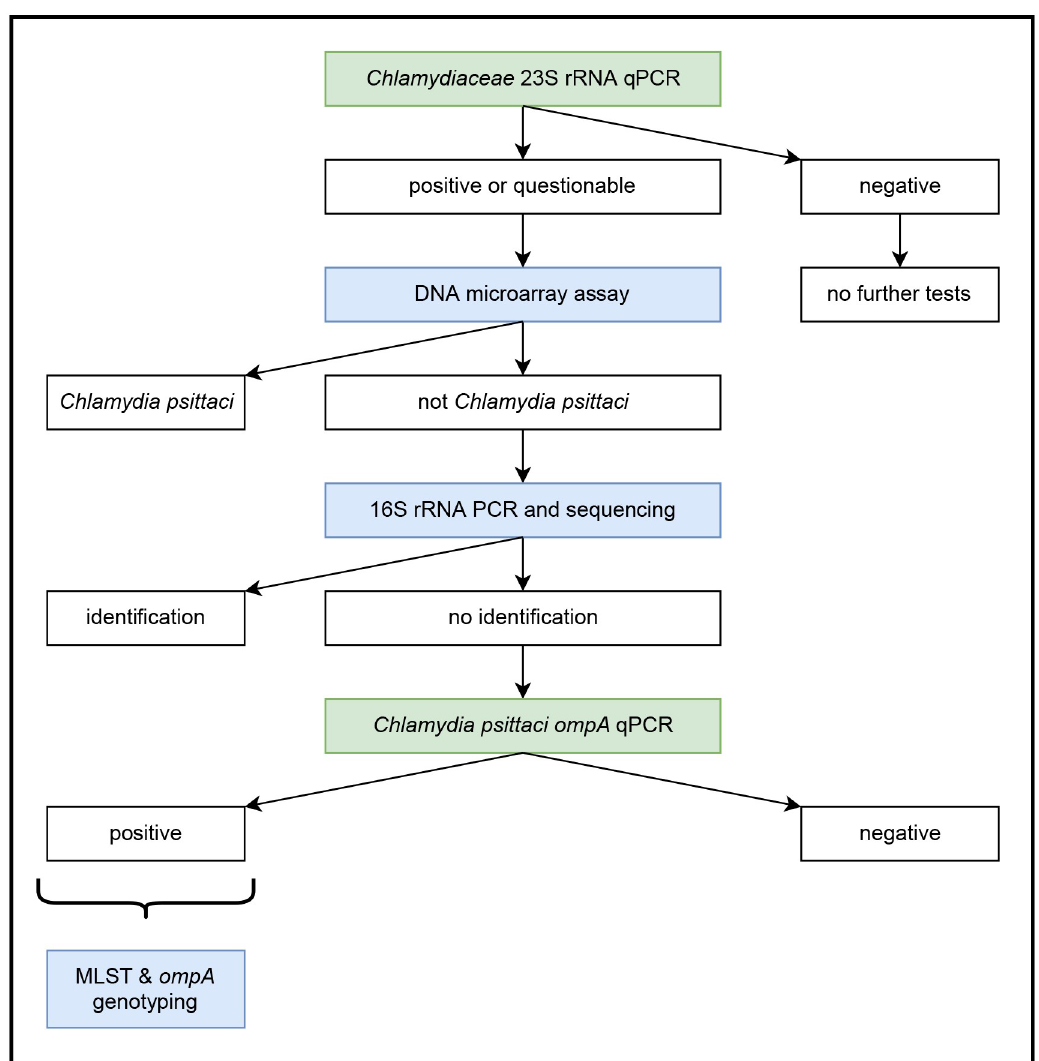
Fig 1. Decision tree for step-wise typing of samples originating from pigeons. Green-colored boxes mark methods using quantitative PCRs, while conventional PCRs are colored in blue. Out of 86 C . psittaci -positive samples, 12 selected samples were further characterized by multilocus sequence typing (MLST) and ompA